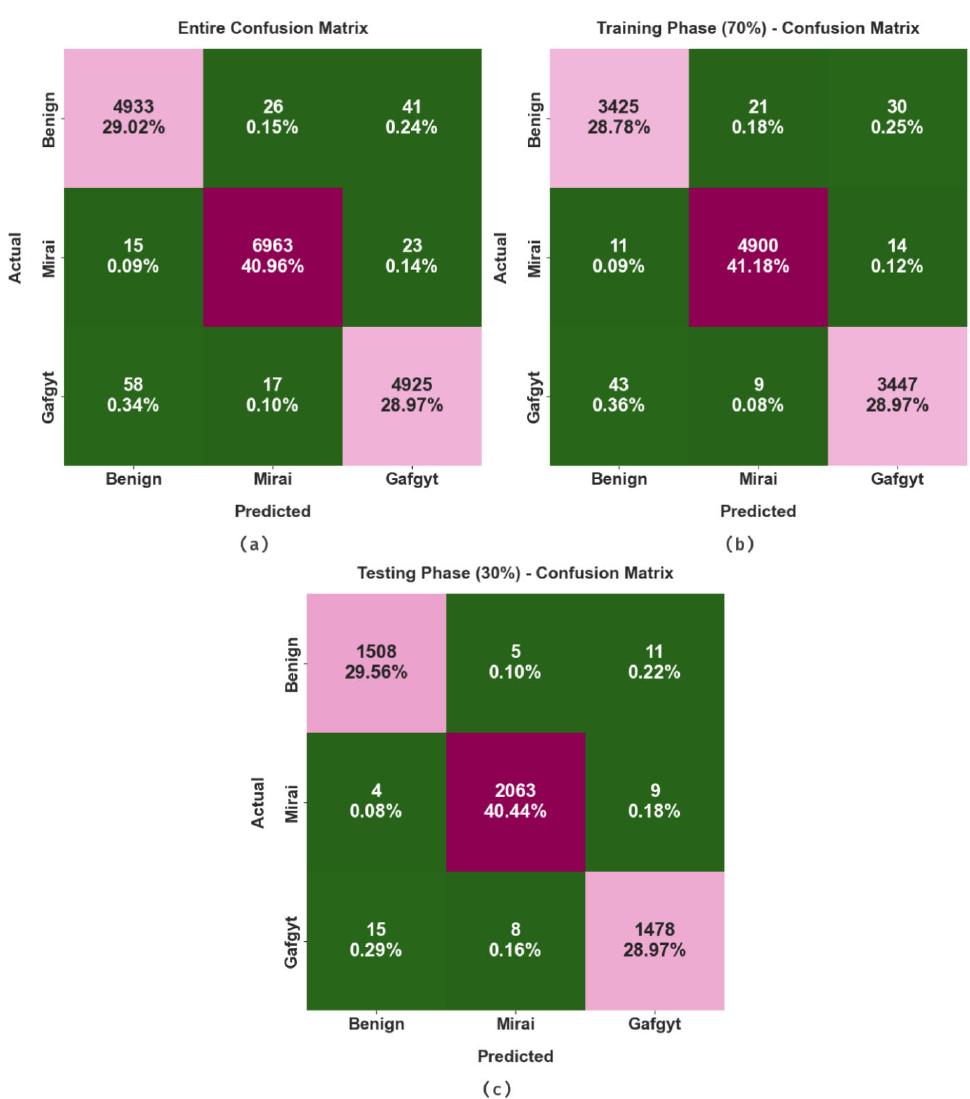
Figure 3. Confusion matrices for BND-BMOML approach: ( a ) entire dataset, ( b ) 70% of TR data, and ( c ) 30% of TS data. Table 3. Result analysis for BND-BMOML algorithm with distinct class labels using 70% of the TR